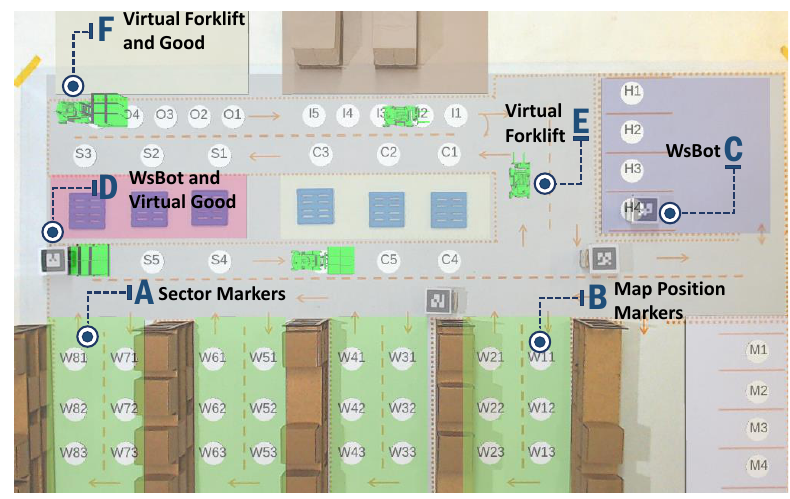
Figure 8. Top view of the AR elements in the